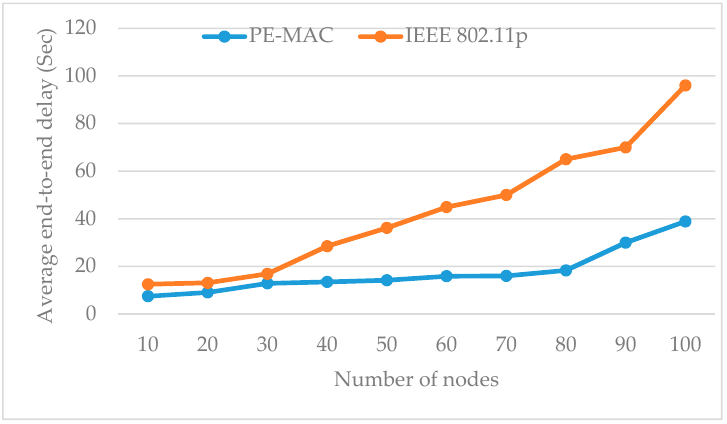
Figure 8. Impact of number of nodes on average end-to-end delay: proposed PE-MAC vs IEEE 802.11p.